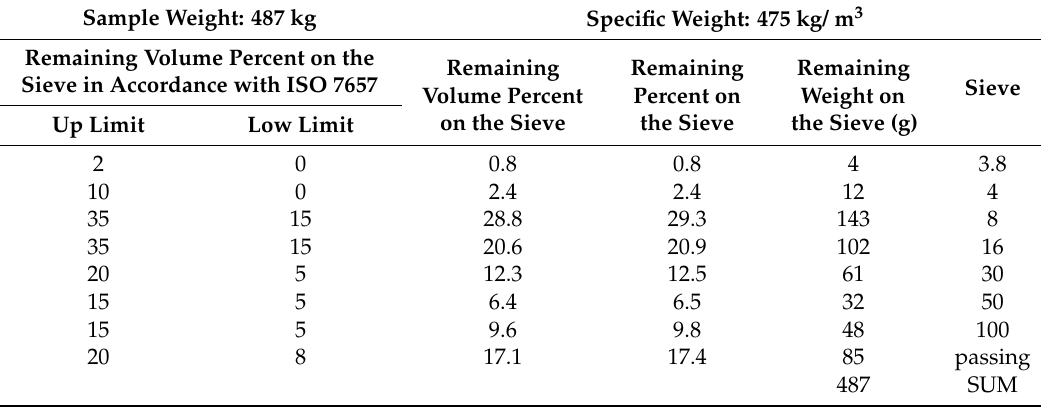
Figure 3. Diagram of the grading of Leca from the Leca company. Table 4. Grading test specifications of Leca from the Leca company.